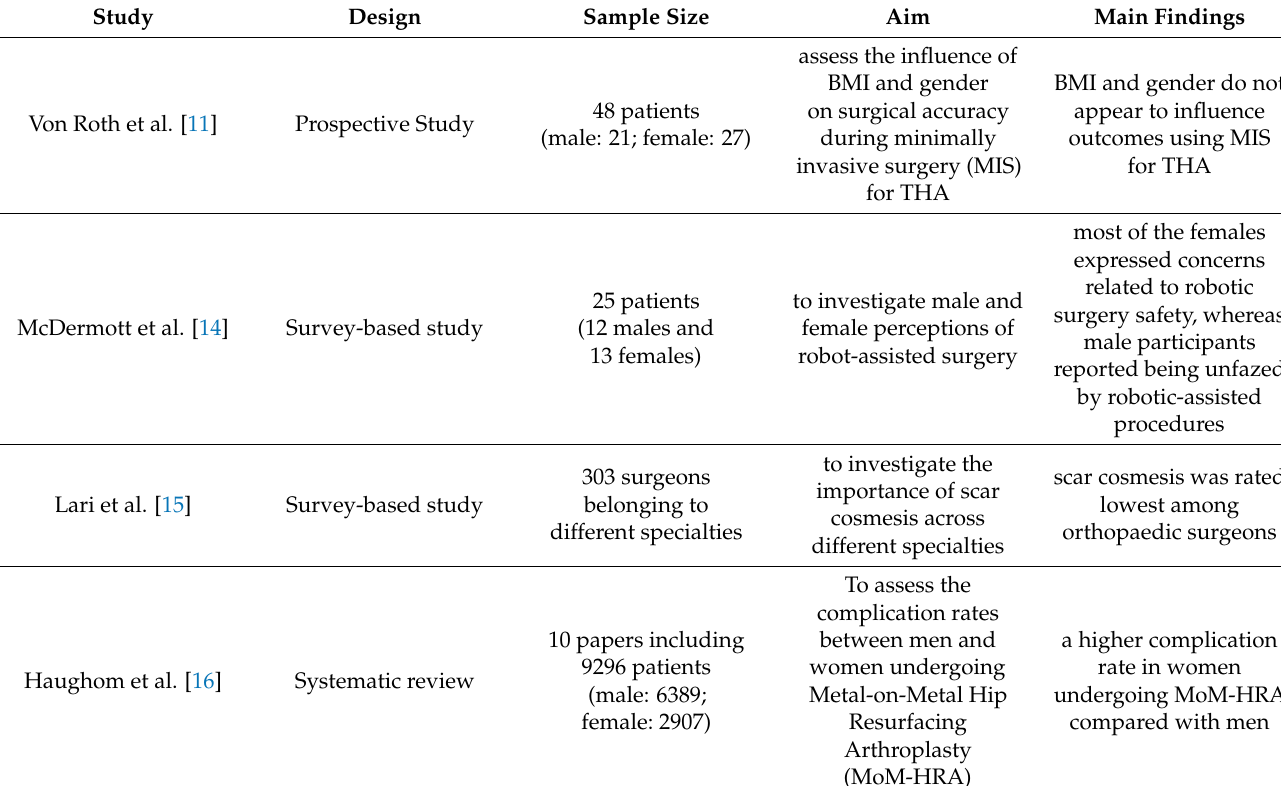
Table 1. Studies investigating surgical approach, robotic surgery, scar cosmesis, and implant choice in relation to sex and